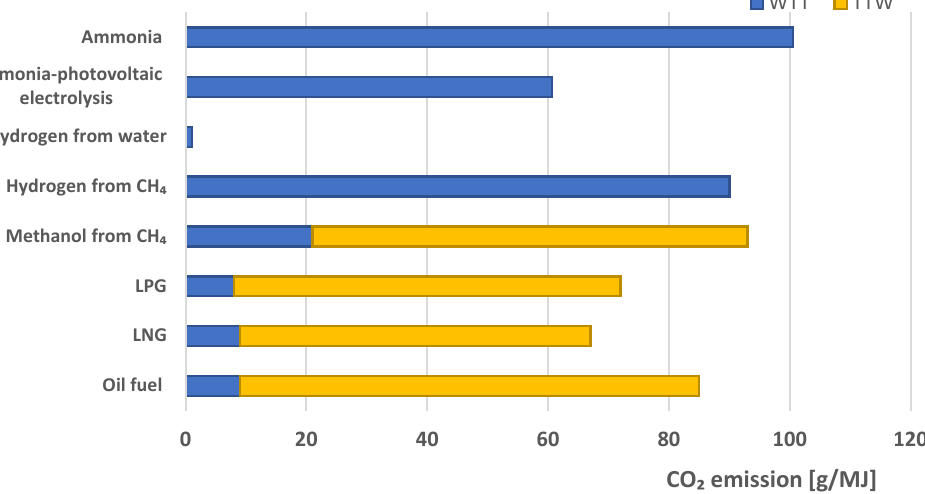
Figure 1. The CO 2 footprints of selected fuel alternatives [23].